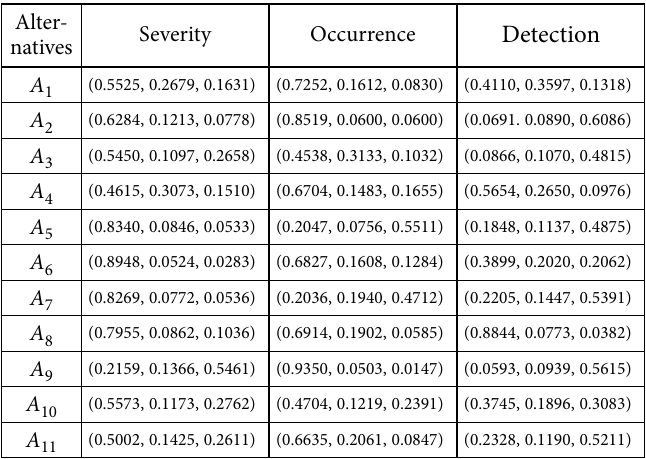
Table 4. Normalized FBS decision matrix Alter- natives